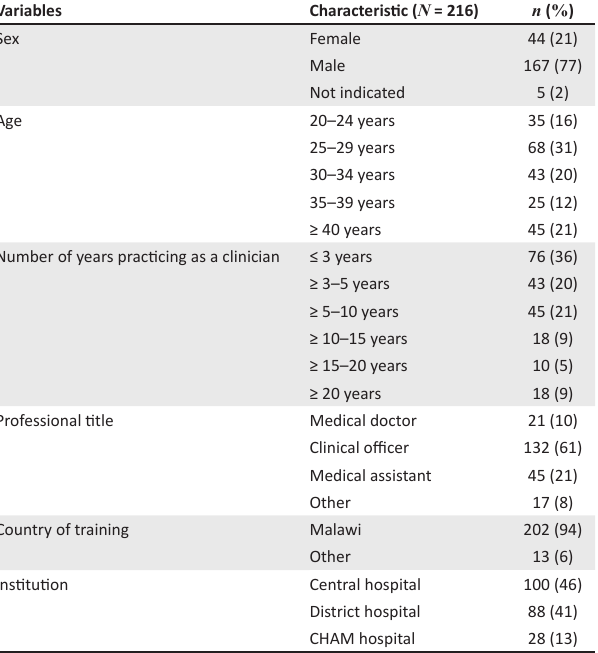
TABLE 1: Characteristics of clinicians in Malawi reporting use of laboratory test results, October–November 2012.